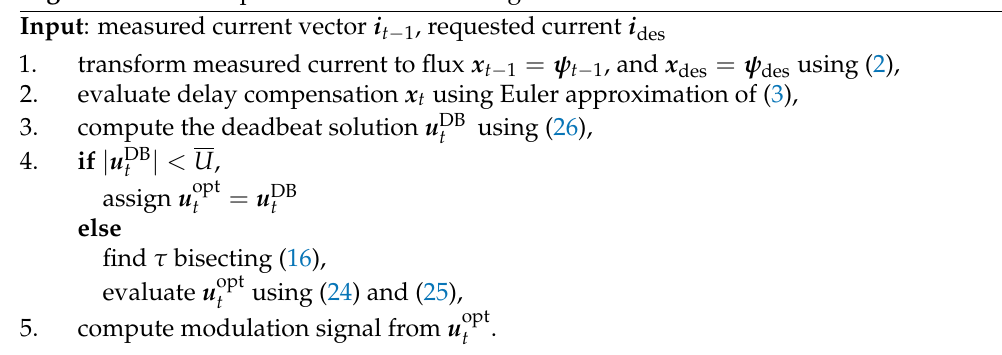
Algorithm 1 Time-optimal current control